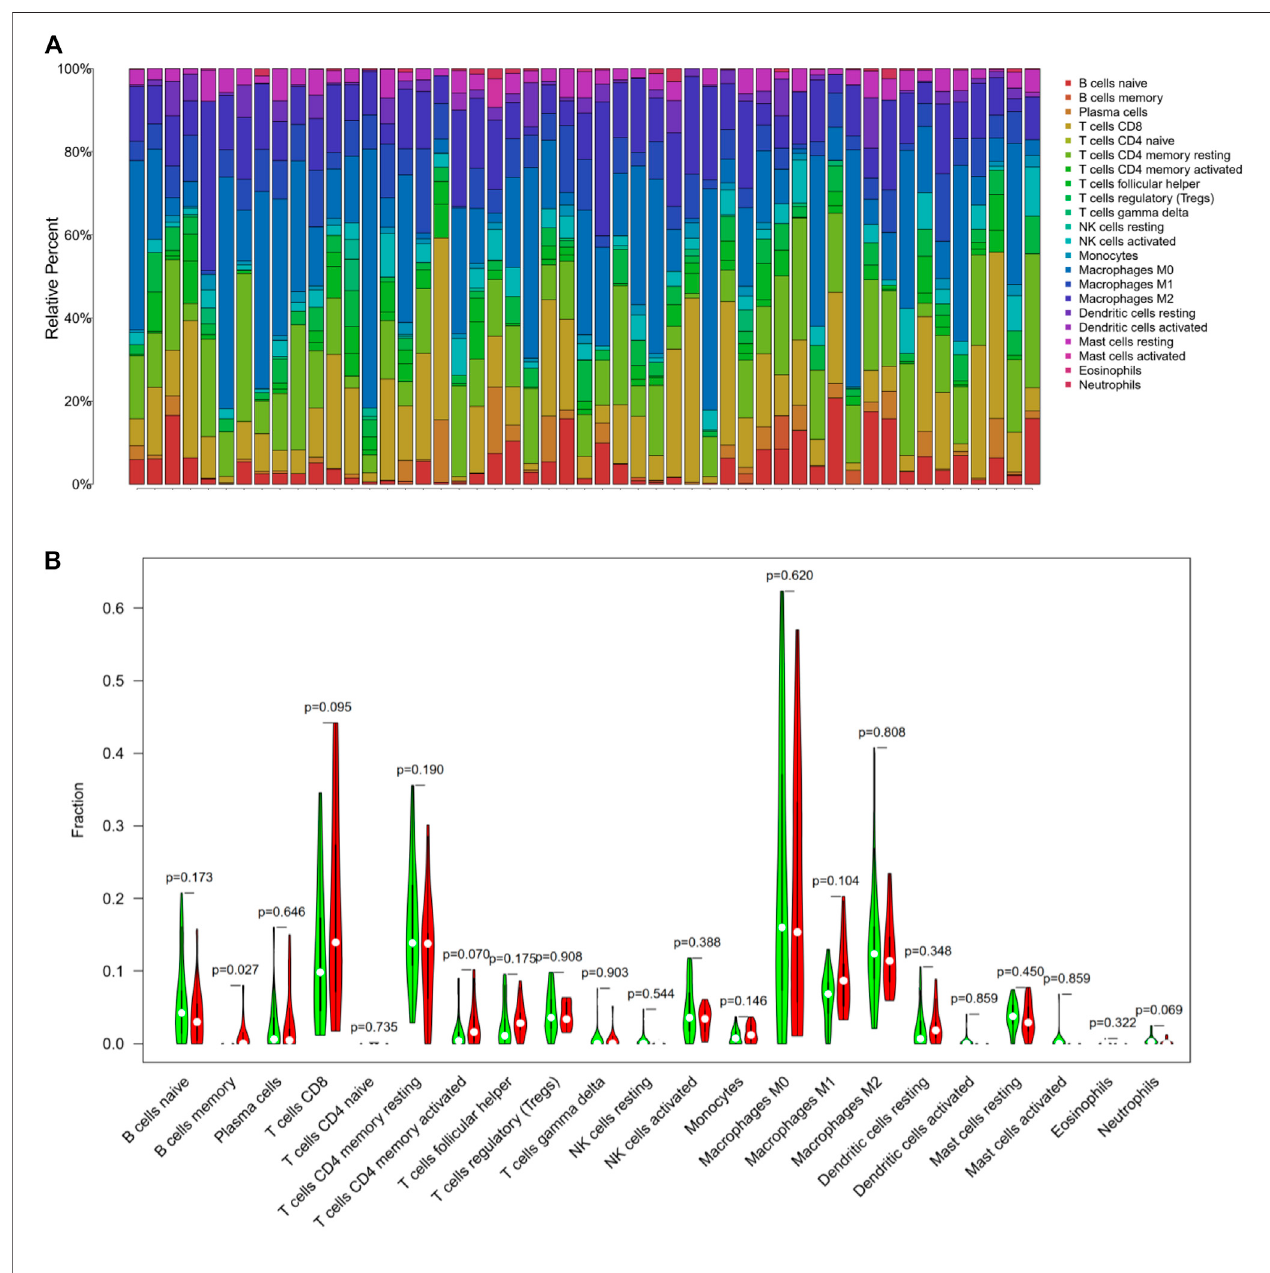
FIGURE4| Tumor-in fi ltratingimmunecells inhepatocellular carcinoma. (A) Thestackedbar graphshowedthein fi ltration of22immunecells ineachsample.Each color represented a type of immune cell. (B) The Wilcoxon rank-sum test displayed that memory B cells ( p (cid:1) 0.02), CD8+ T cells ( p (cid:1) 0.09), CD4+ memory activated T cells ( p (cid:1) 0.07) and neutrophils ( p (cid:1) 0.06) had a difference in high and low TMB